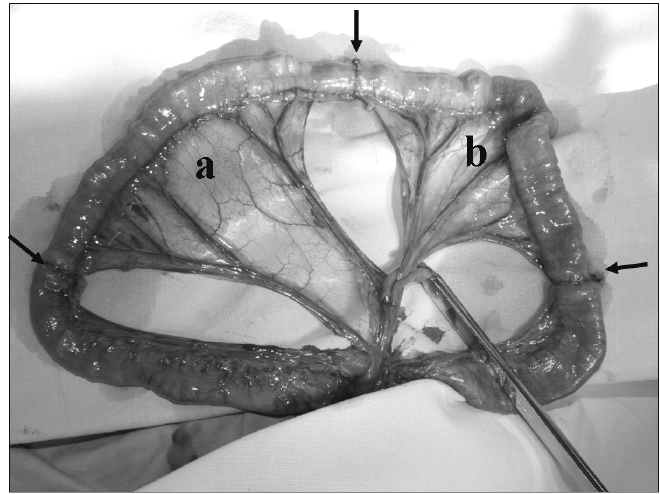
FIgURE 1 - Jejunum segments with 3 intestinal anastomoses. A . Control jejunum segment without clamping. B . Jejunum segment for ischemia- reperfusion investigations (The arrows show the intestinal anastomosis).